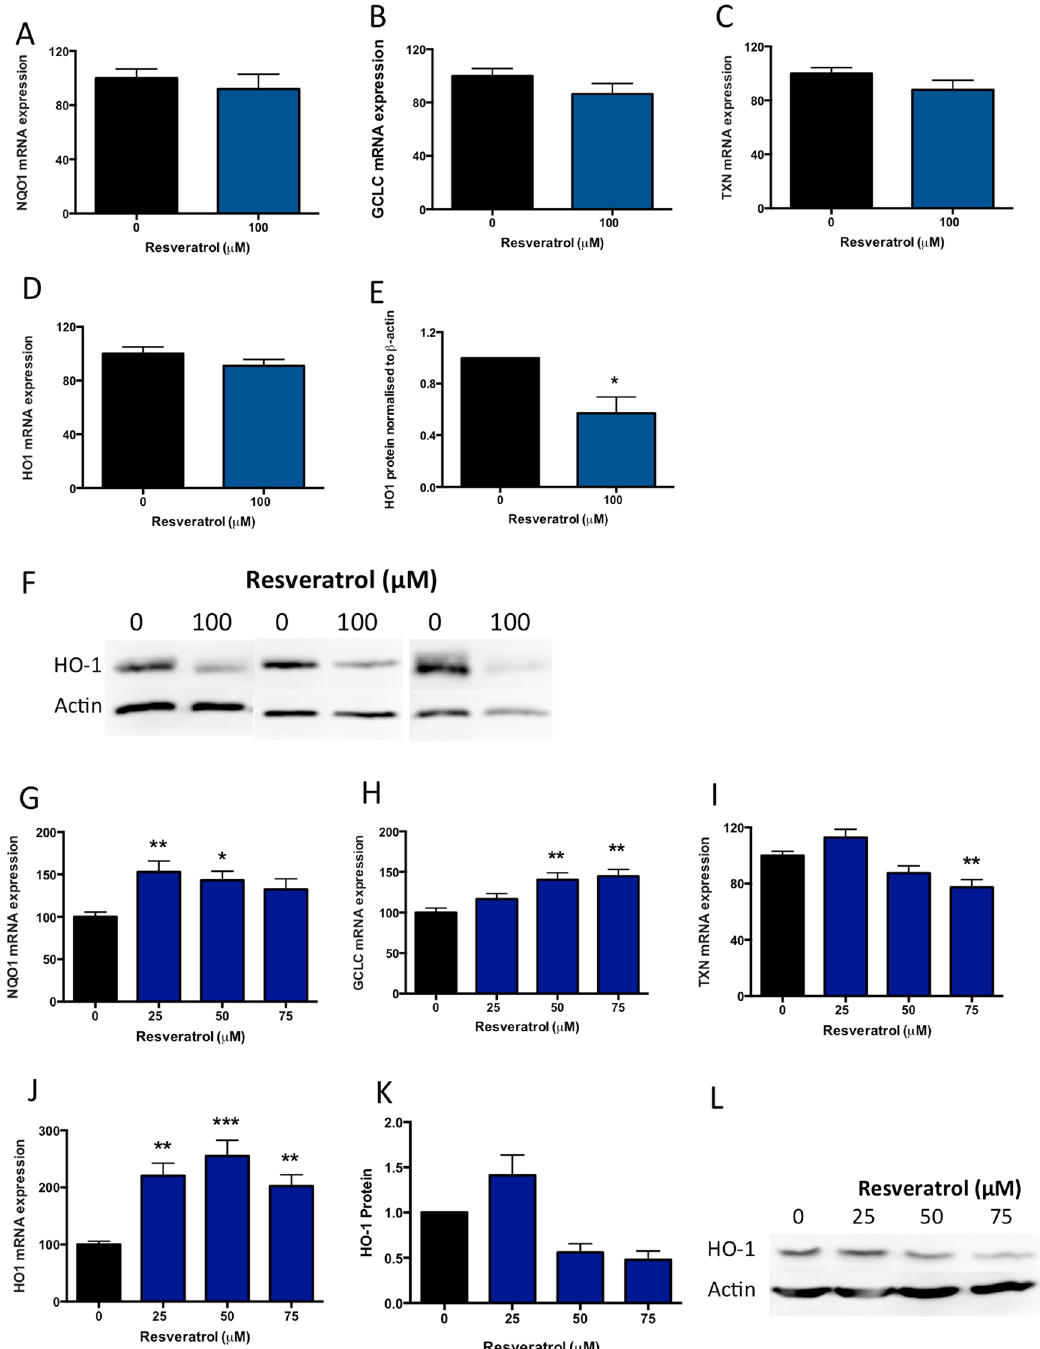
Figure 3. Resveratrol stimulates anti-oxidant molecules in primary HUVECs, but not primary cytotrophoblasts. In primary cytotrophoblast, resveratrol did not significantly alter anti-oxidant response element (ARE) genes ( A ) NQO1, ( B ) GCLC, ( C ) TXN, or ( D ) HO-1 mRNA expression, but significantly reduced HO-1 protein expression assessed via western blot with densitometric analysis ( E–F ). In primary HUVEC, resveratrol significantly induced mRNA expression of ( G ) NQO1, ( H ) GCLC, and ( J ) HO1, but significantly reduced ( I ) mRNA expression of TXN. ( K , L ) Resveratrol did not significantly alter HO-1 protein expression in primary HUVECs. Data expressed as mean ± SEM. * p < 0.05, ** p < 0.01, *** p < 0.001 compared to 0 resveratrol (control). N = 3–5 experimental replicates, with each n taken from a separate patient isolation. F shows a western blot from 3 separate cytotrophoblast isolations, L shows a representative western blot from n = 1 HUVEC experiment, whilst K depicts densitometric analysis of n = 3 separate HUVEC western blots. As indicated in the materials and methods, western blots were cut before antibody exposure and therefore cropped blots are